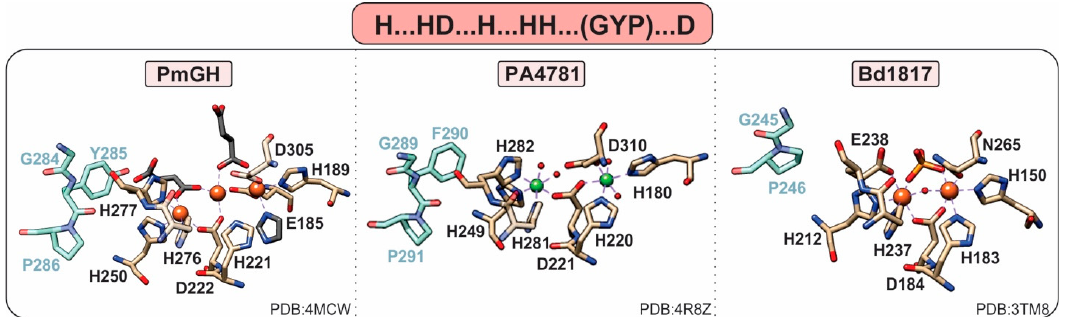
Figure 5. Active site of HD-GYPs. HD-GYP proteins utilize an “H…HD…H…HH…D” motif